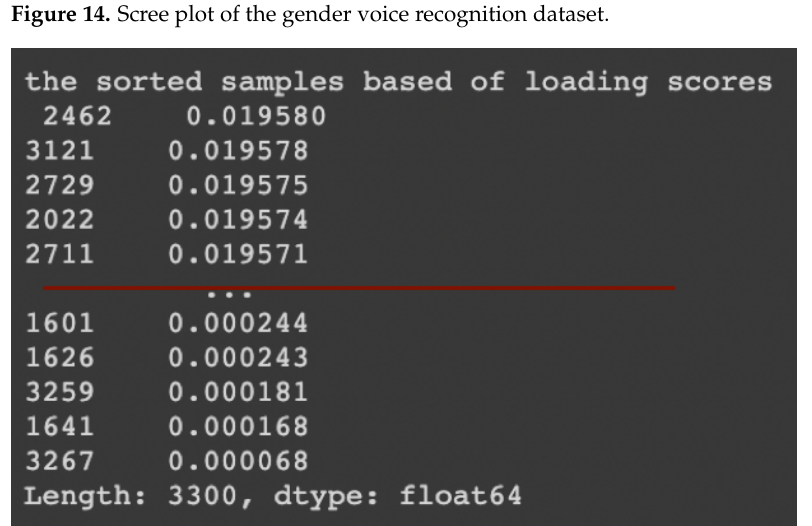
Figure 15. Threshold cutoff limit of the gender voice recognition